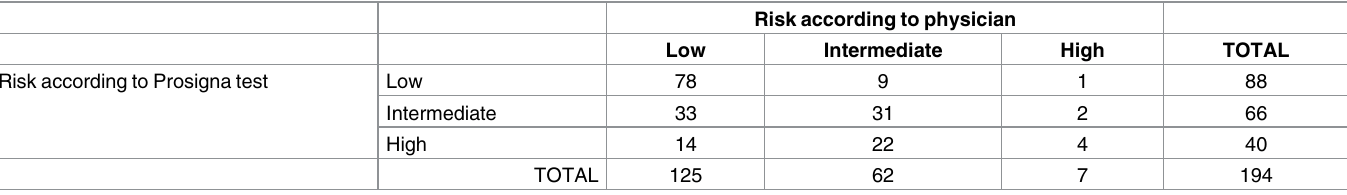
Table 3. Concordance between pre-test physician assessment and Prosigna test results in risk of 10-yeardistant recurrence.